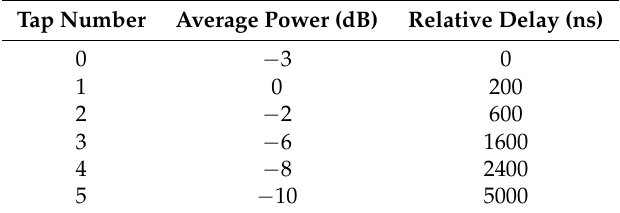
Table 3. Channel